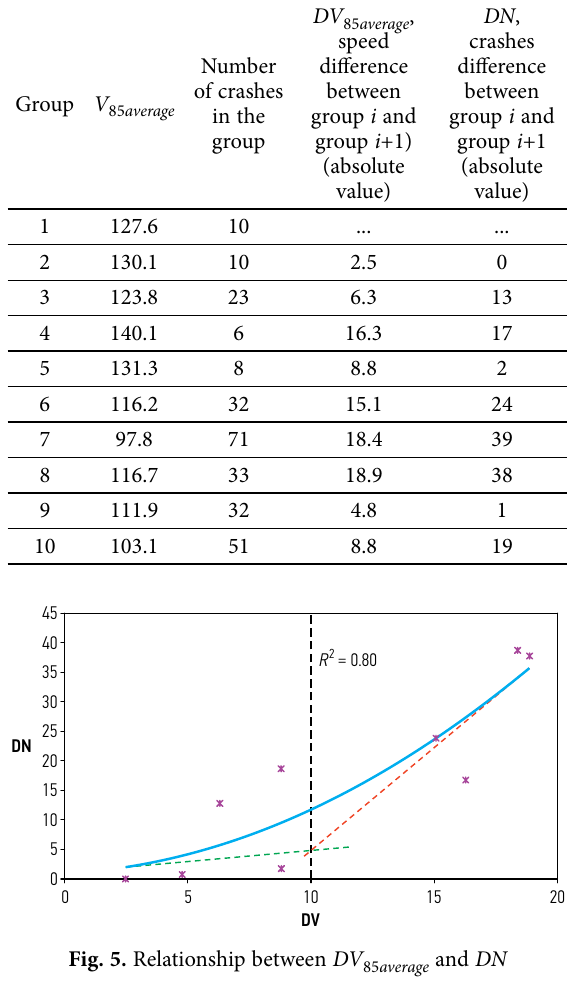
Table 8. Relationship between DV and DN